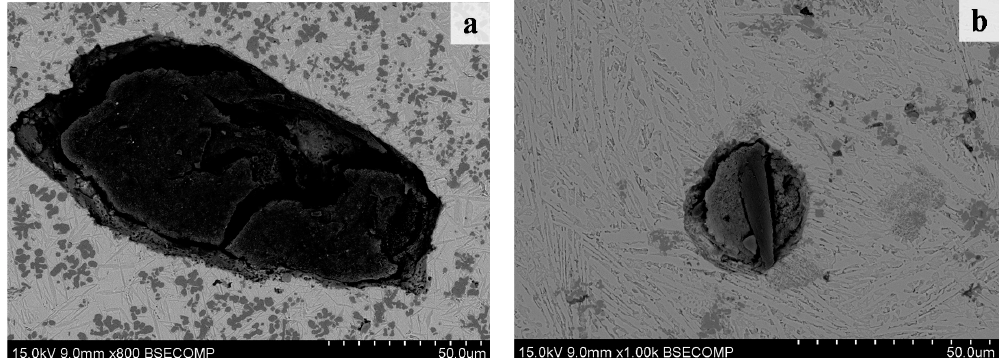
Figure 4. The magnifying BSE images of the black mass in Figure 2. ( a ) Laser cladding zone; and ( b ) transition zone.